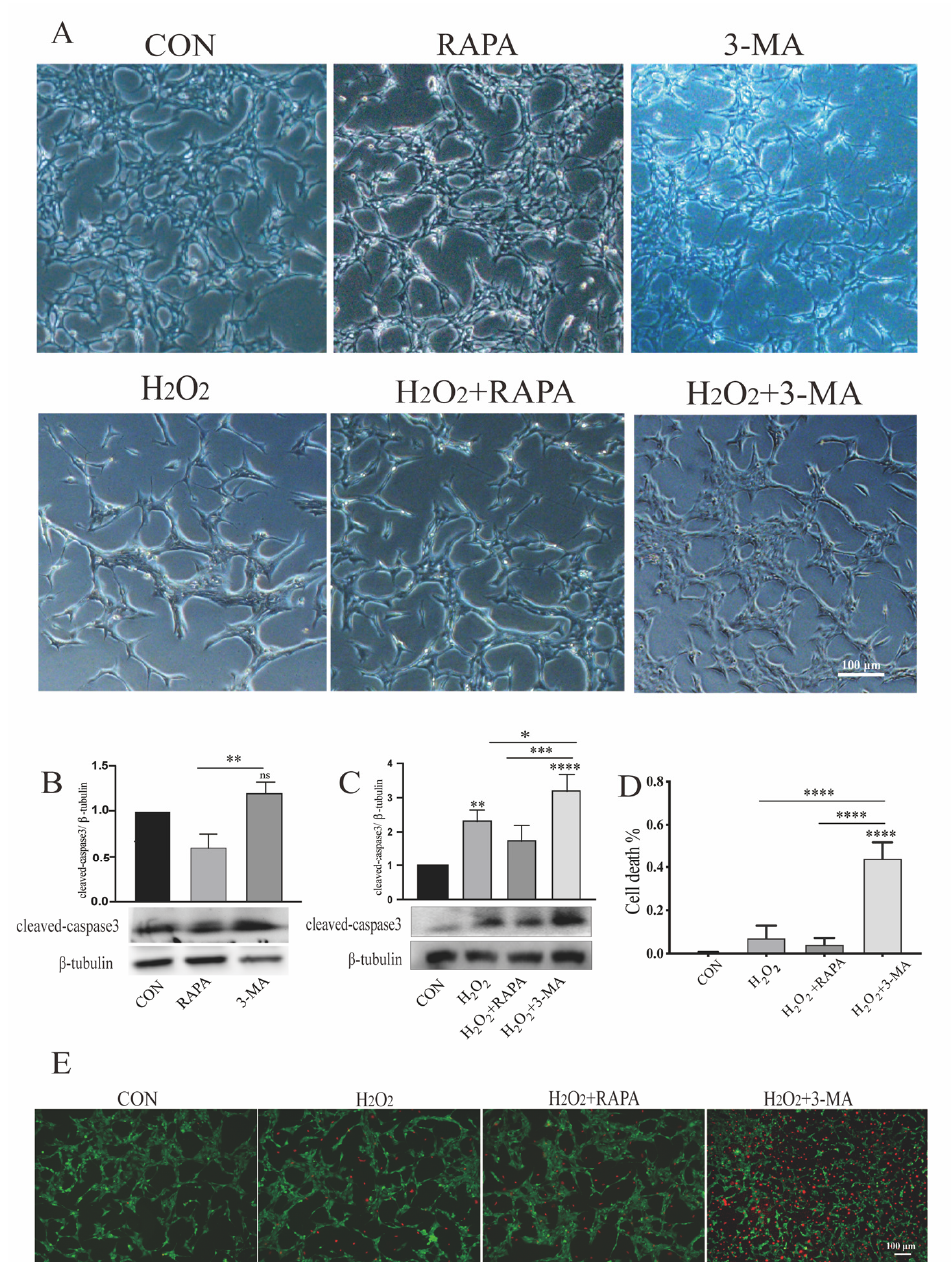
Figure 1. Regulation of autophagy can modulate the morphologic alterations and apoptosis of MGCs under oxidative stress. r-MCs were treated with rapamycin or 3-MA under normal conditions or oxidative stress for 24 h. ( A ) Bright-field microscopy was used to detect the morphologic alterations of MGCs. r-MCs treated with H 2 O 2 and 3-MA formed aggregates. Scale bar: 100 µ m. ( B , C ) Apoptosis of MGCs was detected by changes in the expression of cleaved caspase 3 by western blotting. Appropriate downregulation of autophagy induced by 3-MA (1 mM) was not toxic to r-MCs under normoxia, while it could increase vulnerability to oxidative stress. Data are shown as means ± SEMs ( n = 3 per group; * p < 0.05, ** p < 0.01, *** p < 0.001 and **** p < 0.0001). ( D ) Cell death in different groups was quantified. Data are shown as means ± SEMs ( n = 3 per group; **** p < 0.0001). ( E ) Live/dead cell staining for oxidative stress and autophagic dysfunction showed obvious MGC apoptosis. Scale bar: 100 µ m. RAPA, rapamycin; 3-MA, 3-methyladenine.